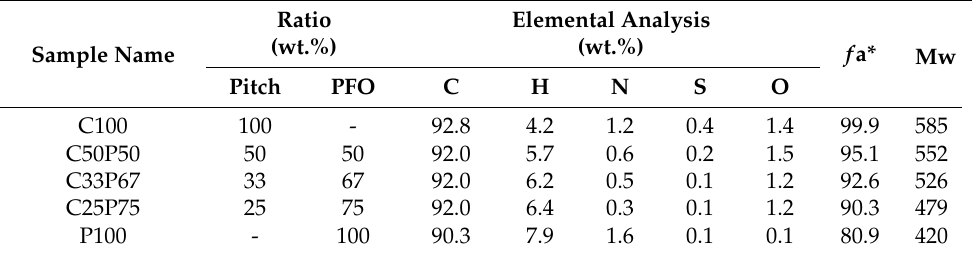
Table 3. Elemental analyses of spinnable pitches prepared by co-carbonization of purified coal tar pitch and PFO in various